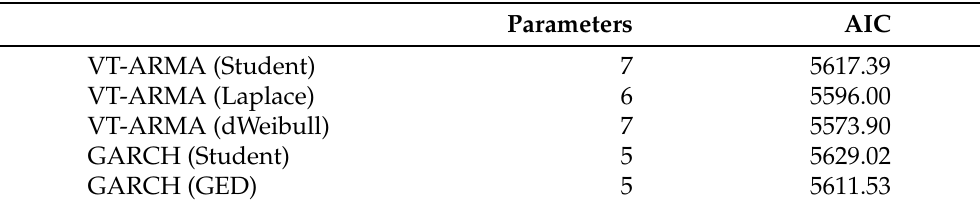
Table 3. Comparison of three VT(2)-ARMA(1,1) models with different marginal distributions with two GARCH(1,1) models with different innovation